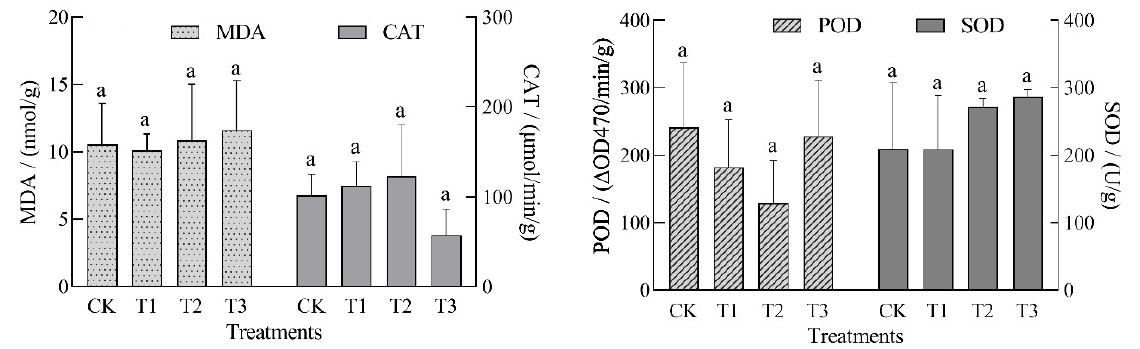
Figure 6. Effects of different treatments on MDA content and three antioxidant enzymes’ activity in tobacco leaves. Note: Different lowercase letters indicate that the differences between treatments reached a significant level ( p < 0.05).